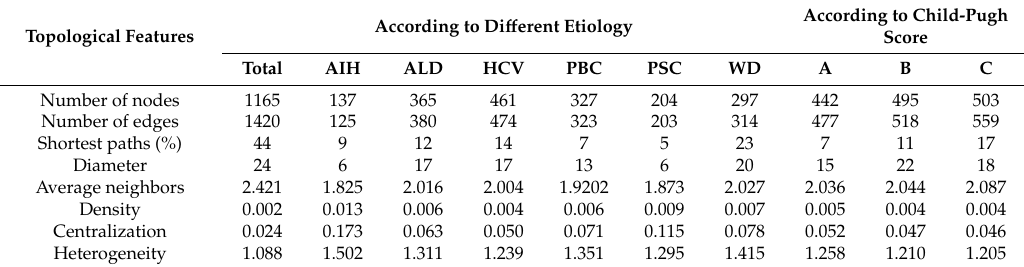
Table 3. The topological features of the miRNA–gene target differential regulatory network for each condition. Table 4. Summary of deregulated key DEMs with maximum degree, betweenness centrality, and closeness centrality identified in di ff erent conditions of liver disease.